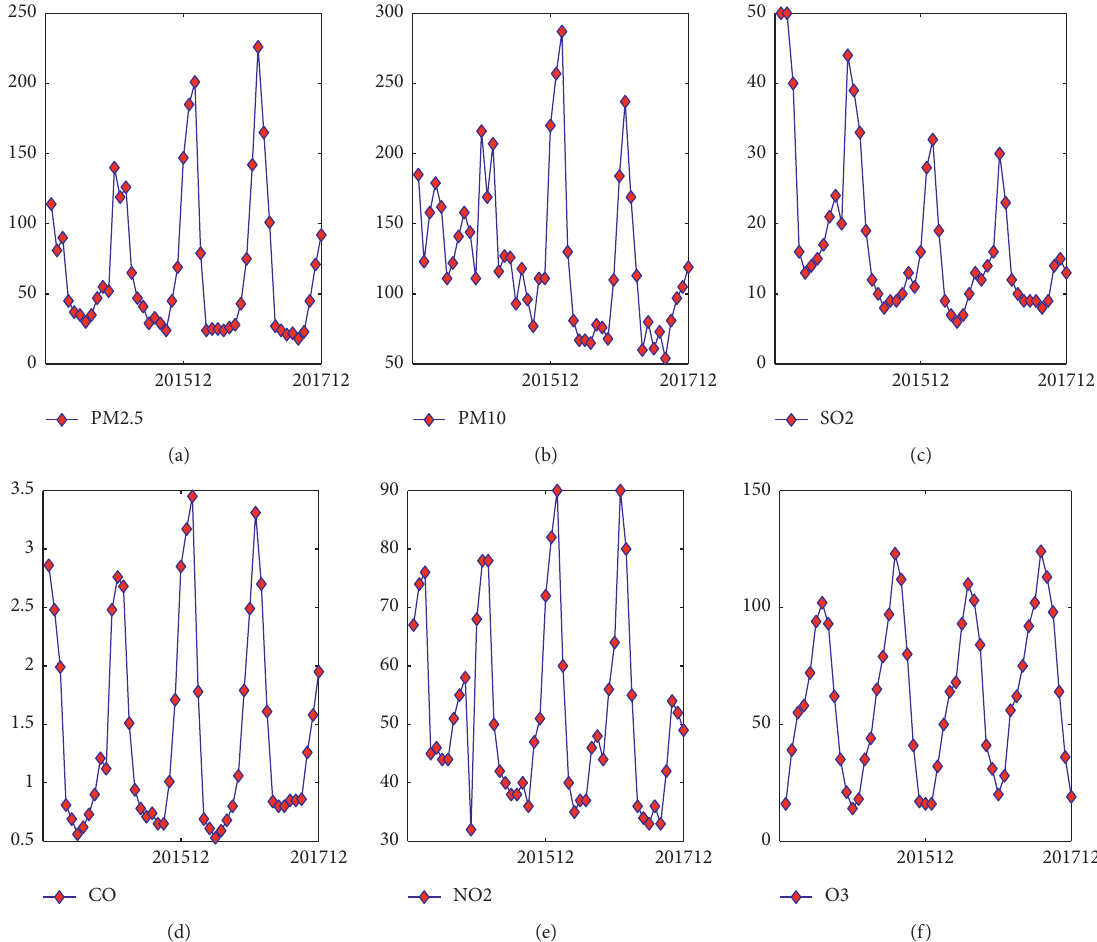
Figure 3: Time series chart of data on six air pollution variables from January 2014 to December 2017.